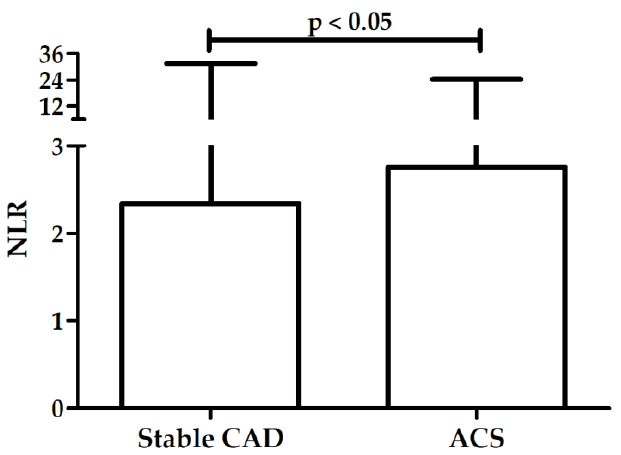
Figure 1. Difference in NLR between patients with stable CAD and patients with ACS, box—median, whiskers—range.